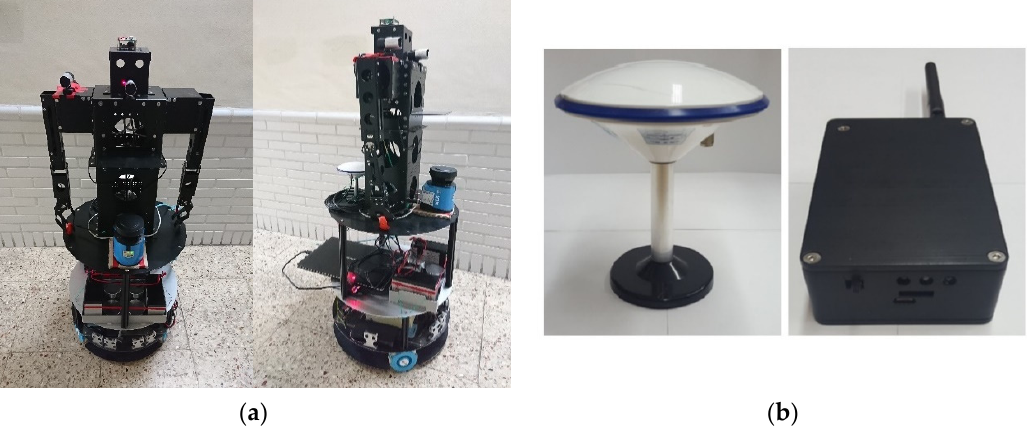
Figure 1. ( a ) The omnidirectional WMR with webcam, laser sensor, ultrasonic sensors, GNSS RTK positioning system, StarGazer positioning system, and notebook; ( b ) the GNSS antenna and the GNSS receiver [8].